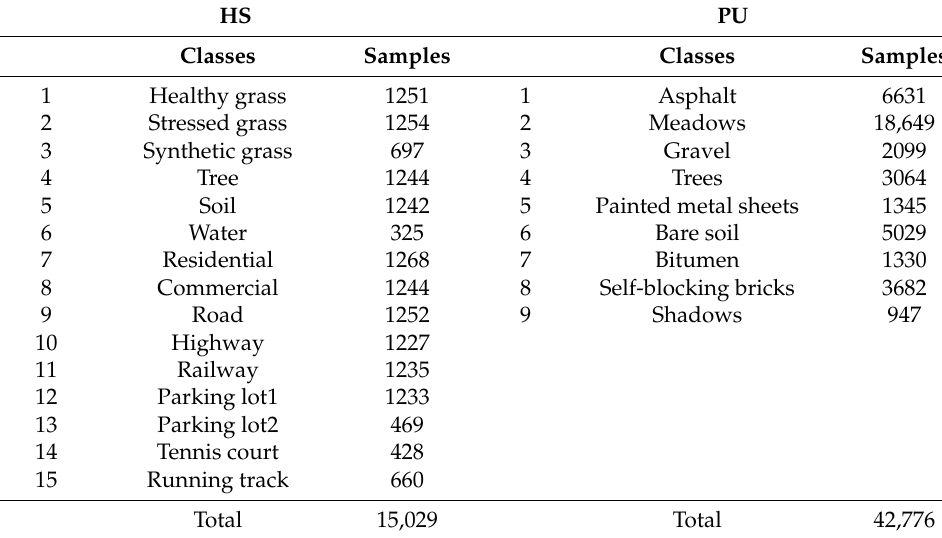
Table 2. Categories and sample numbers of the HS and PU